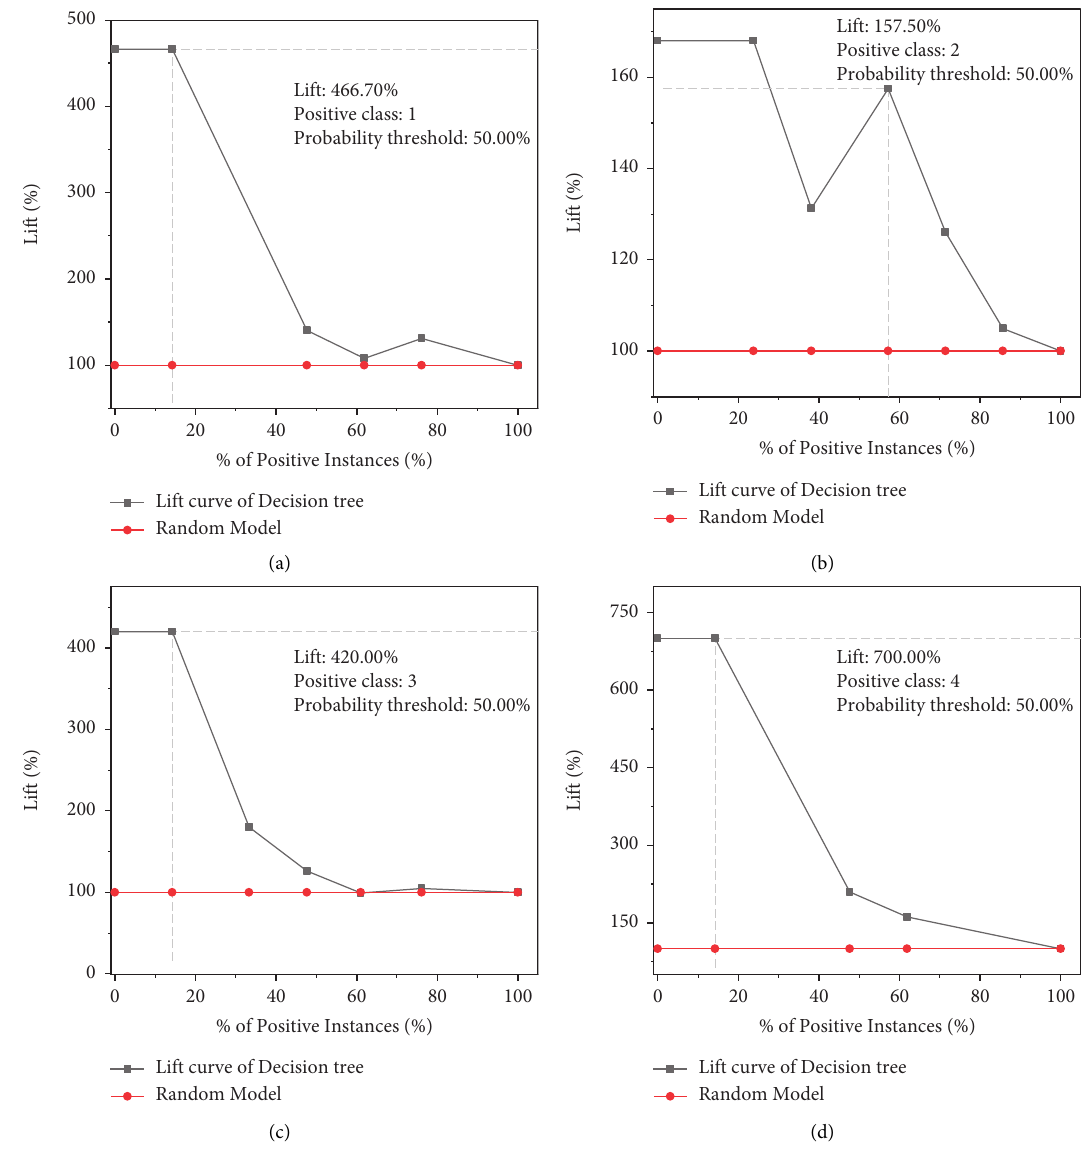
Figure 13: Lift curve of each classification test of the decision tree